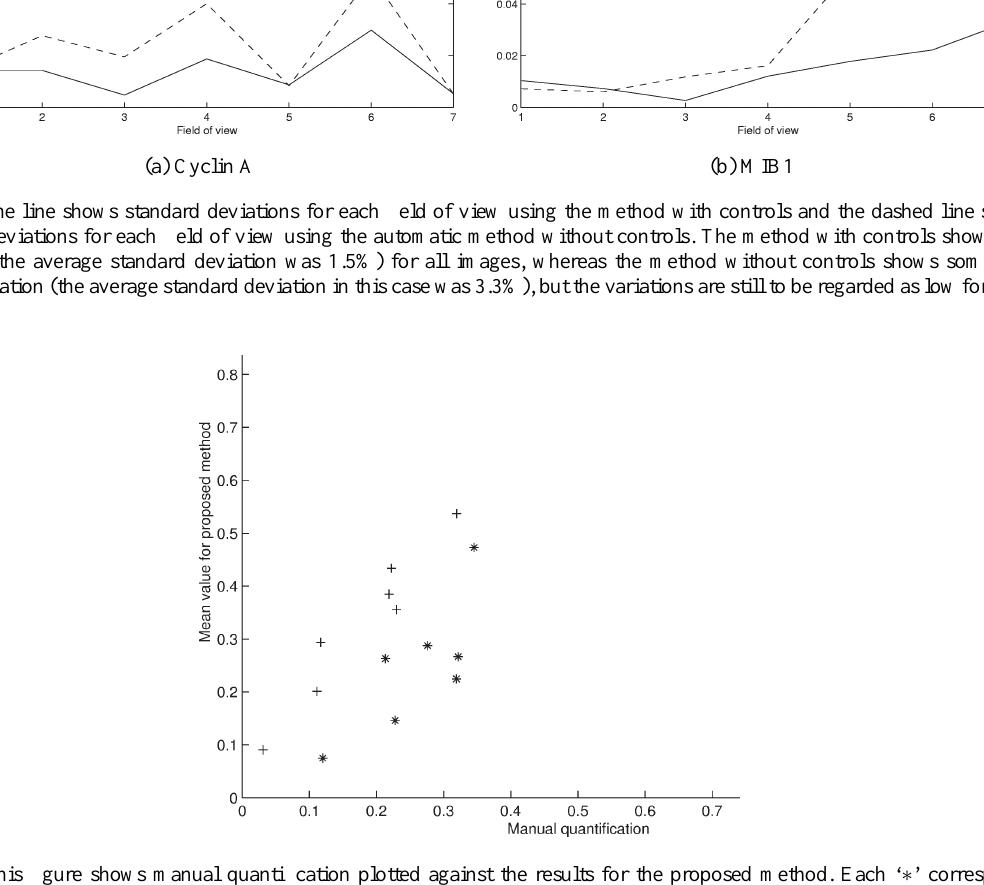
Fig. 13. This figure shows manual quantification plotted against the results for the proposed method. Each ‘ (cid:3) ’ corresponds to one field of view for MIB1 and each ‘ + ’ corresponds to one field of view for Cyclin A. Since the manual quantification measured number of objects and the automatic method measured areas, we cannot expect to get exactly the same values. What is important is if the correlation is good. This test gave the correlation coefficient r = 0 : 968 for the Cyclin A images, and r = 0 : 782 for the MIB1 images. The overall correlation coefficient was r = 0 :